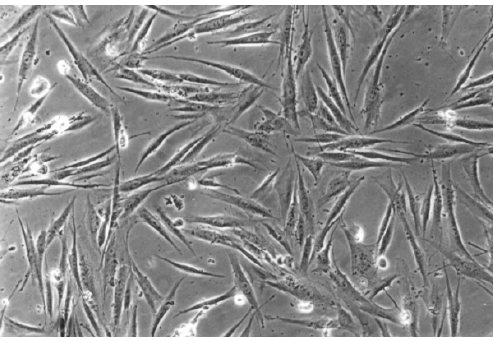
Table 9. Qualitative evaluation: Optibond Solo Plus (No. 6).